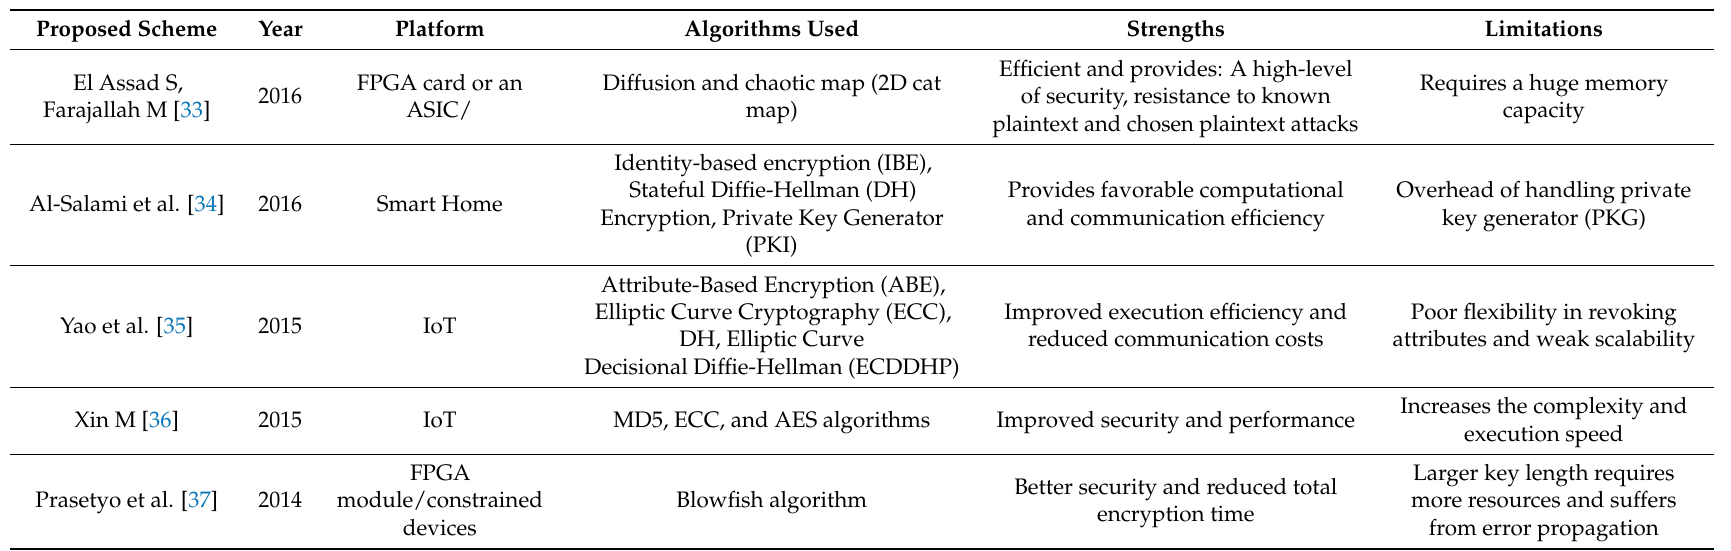
Table 1. Summary of recently proposed security schemes for IoT by using existing standardized encryption